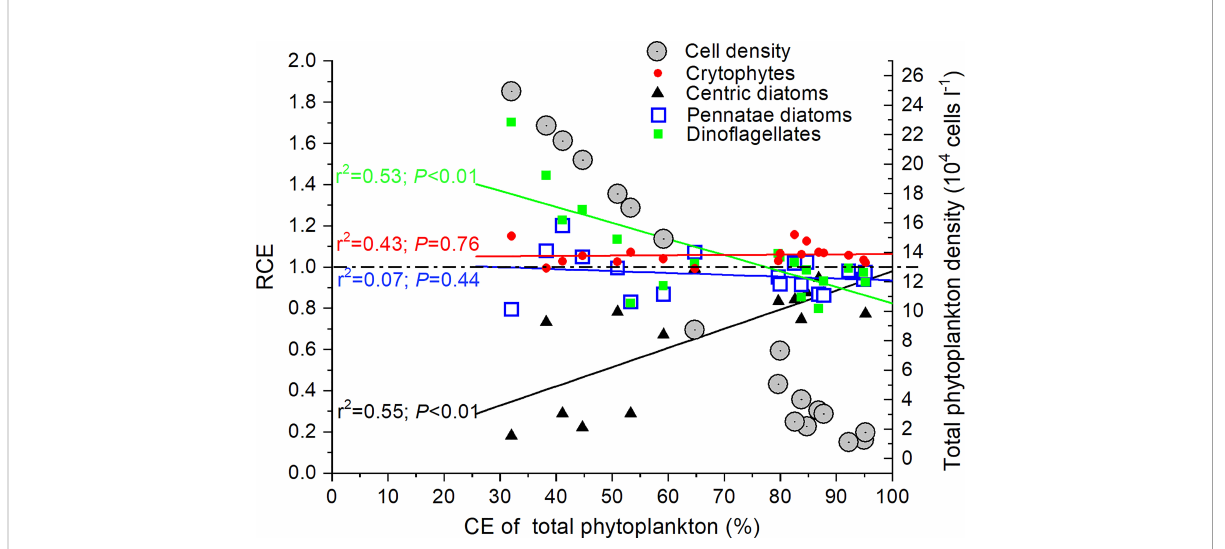
FIGURE 5 The relationship between the ratio of clearance ef fi ciency of different phytoplankton groups against total phytoplankton (RCE) and CE of total phytoplankton by M. coruscus